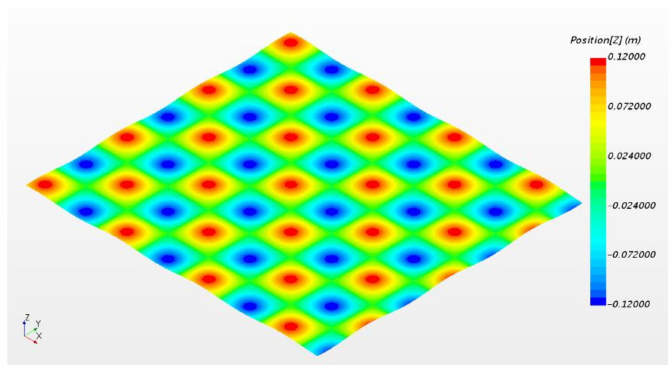
Figure 9. Example of the simulated cross wave